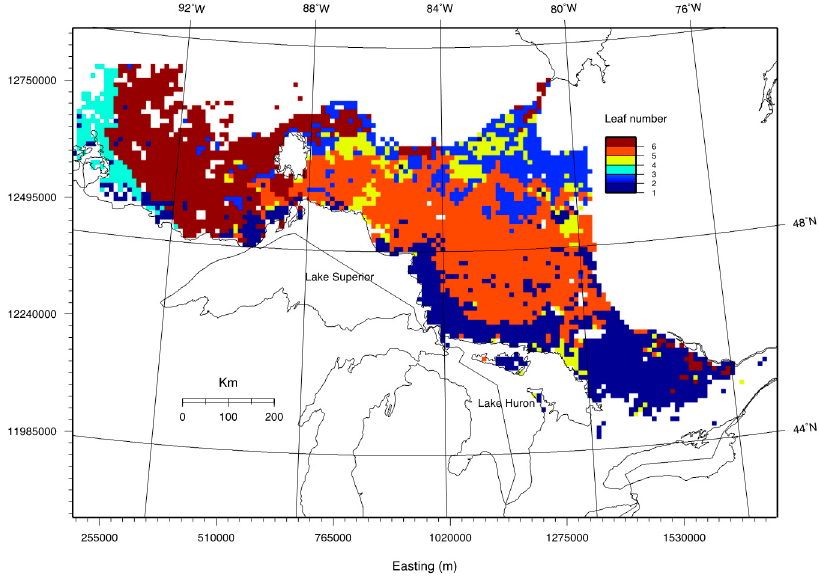
Figure 4. Areas uniquely associated with each leaf of the classification tree in Figure 3.